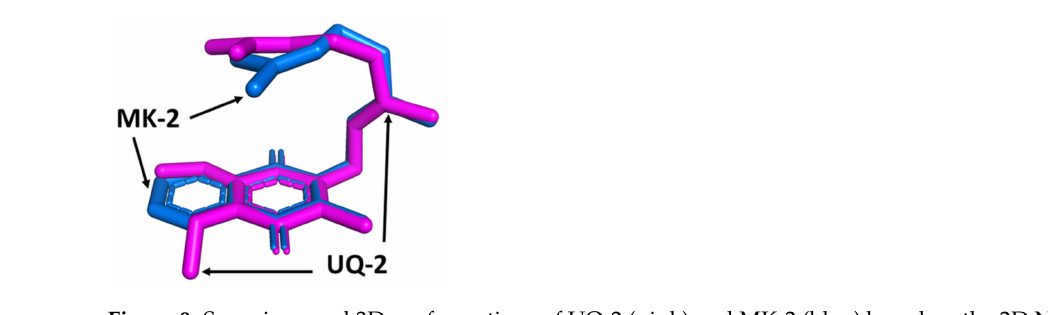
Figure 9. Superimposed 3D conformations of UQ-2 (pink) and MK-2 (blue) based on the 2D NMR data in DMSO. This figure was originally published in Ref. [41] and is licensed under CC-BY 4.0. The original figure was modified to include only the depicted